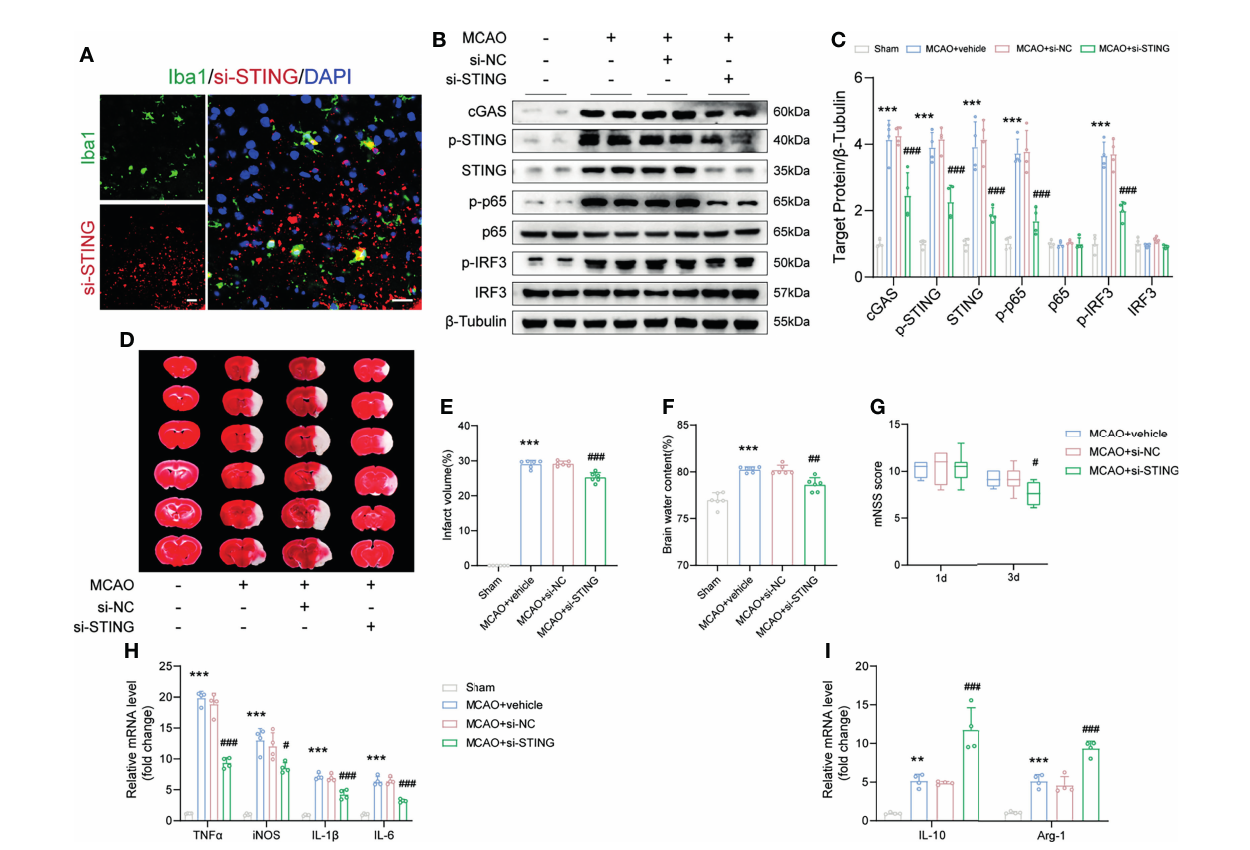
FIGURE 5 | STING knockdown ameliorated brain infarction and edema, promoted neurological recovery and rescued the expression of anti-in fl ammatory genes. (A) si-STING (red) co-stained with Iba1 (green) 1d post-MCAO in mice receiving Cy5-conjugated si-STING. (B, C) Immunoblots and quantitative analysis of STING- related proteins, including cGAS, p-STING, STING, p-p65, p65, p-IRF3 and IRF3 of Sham, MCAO+vehicle, MCAO+si-NC and MCAO+si-STING mice 1d after MCAO. n = 4. (D-F) Representative images of TTC staining and quantitative analysis of infarct volume and brain edema 1d post-MCAO. n = 6. (G) mNSS score of the indicated groups at day 1 and day 3 after MCAO. n = 8. (H, I) Relative mRNA expression of M1 microglia-speci fi c transcripts (TNF a , iNOS, IL-1 b and IL-6) and M2 microglia-speci fi c transcripts (IL-10 and Arg-1). n = 4. Data are expressed as mean ± SD. ** P < 0.01, *** P < 0.001 vs Sham group; # P < 0.05, ## P <